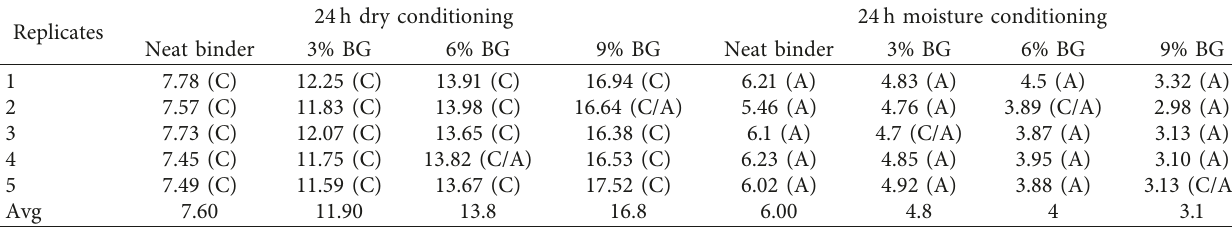
Figure 11: Effect of stress level on J Table 7: POTS (psi) of unmodified and BG-modified binders and failure pattern. Replicates